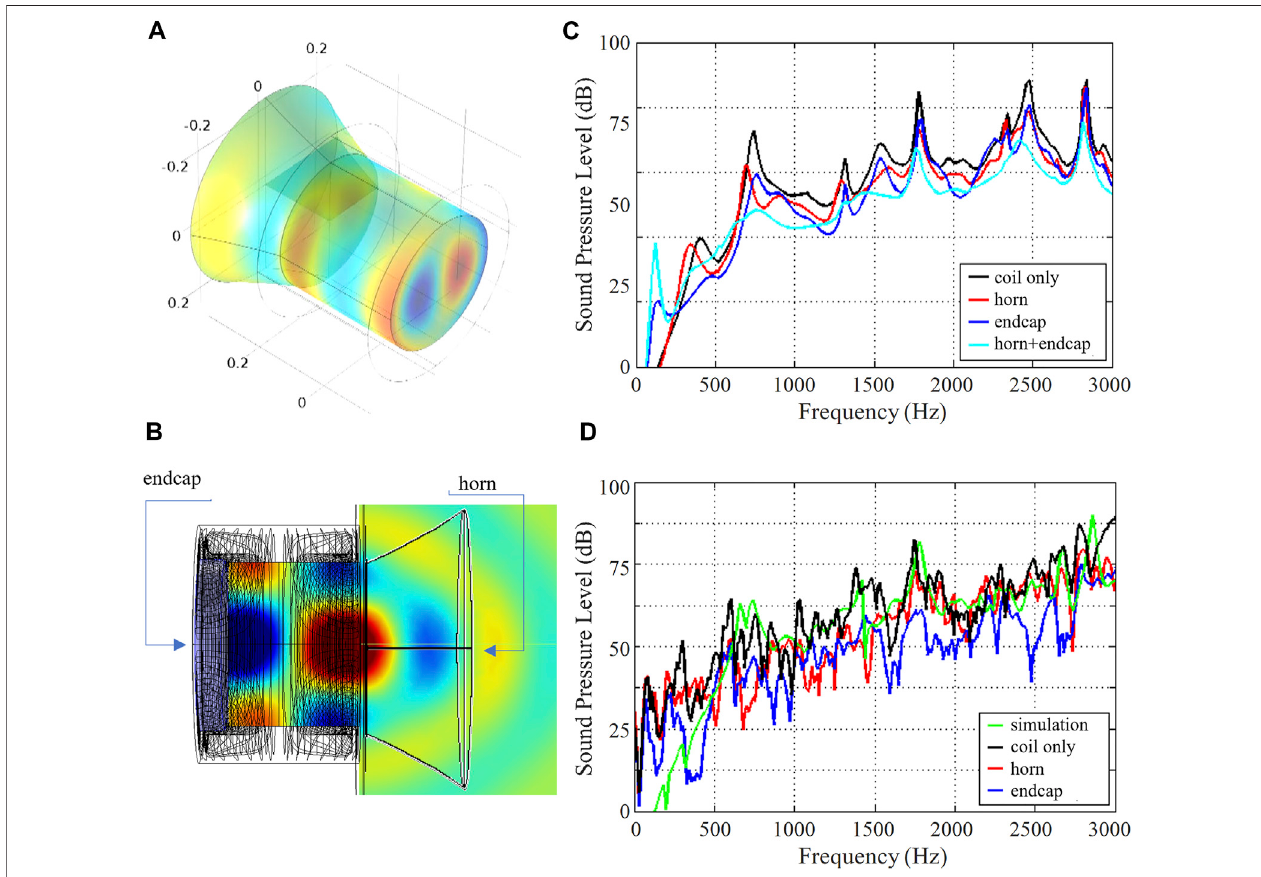
FIGURE 9 | Noise reduction using a horn and endcaps. (A) 3D representation of a gradient coil with an additional horn structure for noise guidance and suppression. (B) 2D representation of the gradient coil with a horn and an end cap. (C) Simulated SPL spectrum. (D) Measured SPL spectra.